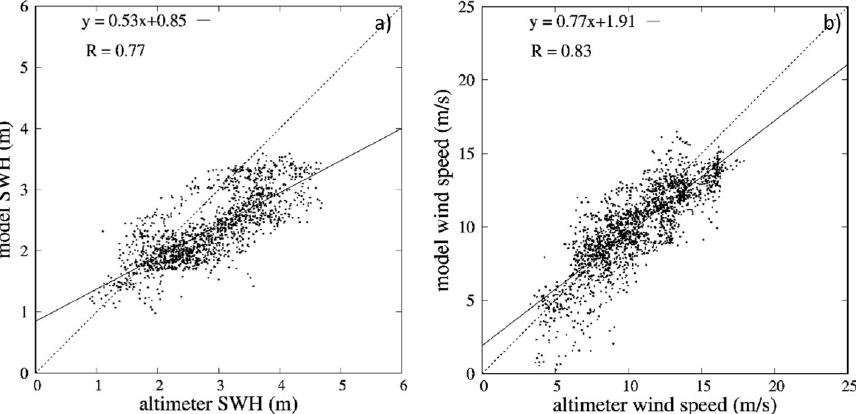
Figure 5. Scatter diagram of SWH ( a ) and wind speed ( b ) from altimeter data and simulation results (“AWO” experiment). Regression line, regression equation and correlation coefficient are also shown. Table 3. Statistical characteristics of model errors in SWH (m) when compared with the altimeter data during the period 10 – 12 December 2006.